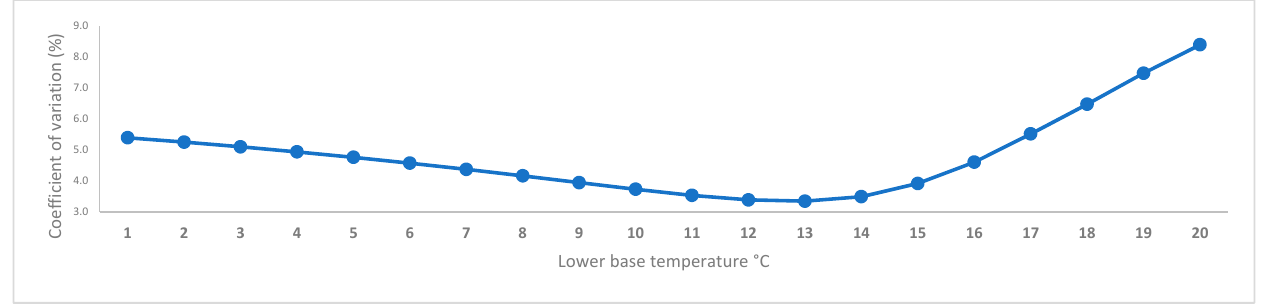
Figure 2. Coefficient of variation for GDD calculated using different lower base temperatures (Tb). Data of three flowering events of the southern-most farm of this study, Bungundarra, QLD (Table A1).